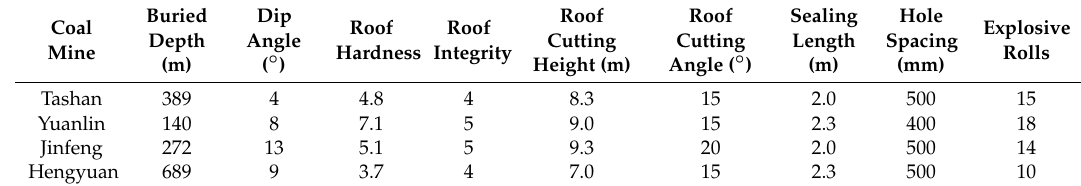
Table 6. Sample set of blasting parameters for back propagation (BP) neural